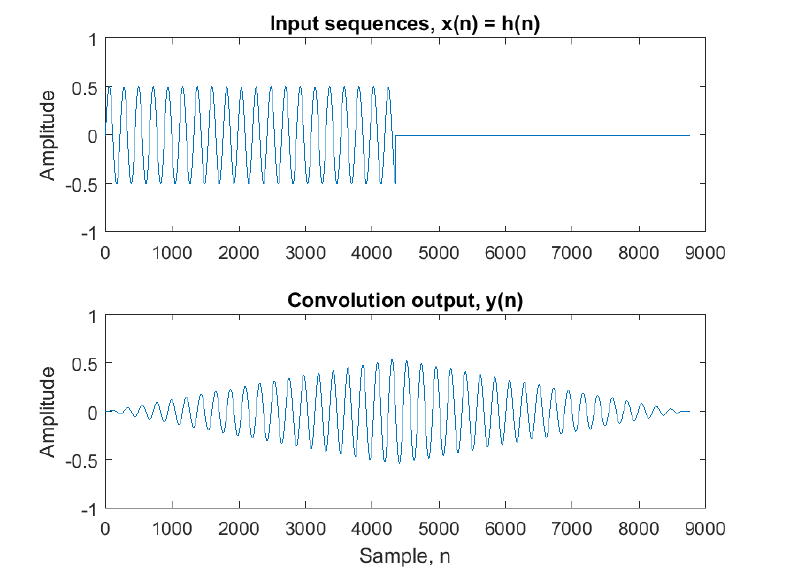
Figure 1. Convolving a time-limited sine sequence with